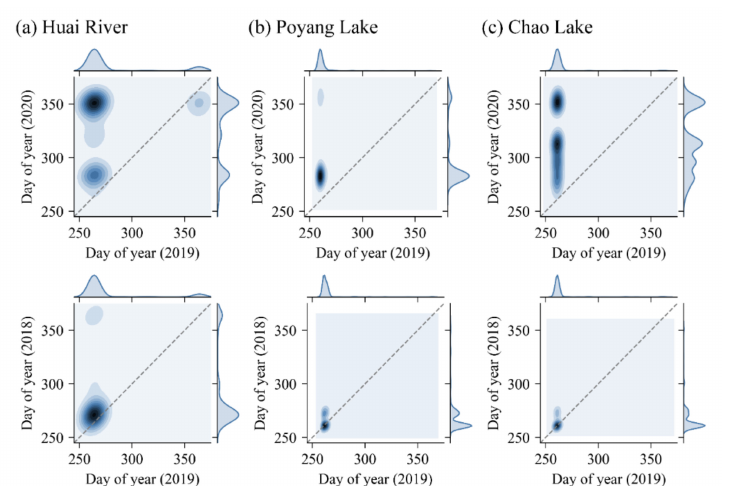
Figure 11. Joint kernel density estimation (KDE) plots show DOY delays of maximum NDVI due to flood disasters in 2020 compared with 2019 and 2018 in the three study areas: ( a ) the Huai River Region; ( b ) the Poyang Lake Region; ( c ) the Chao Lake Region. The KDE plots were generated by 5000 random points within the recovered flood-affected croplands.